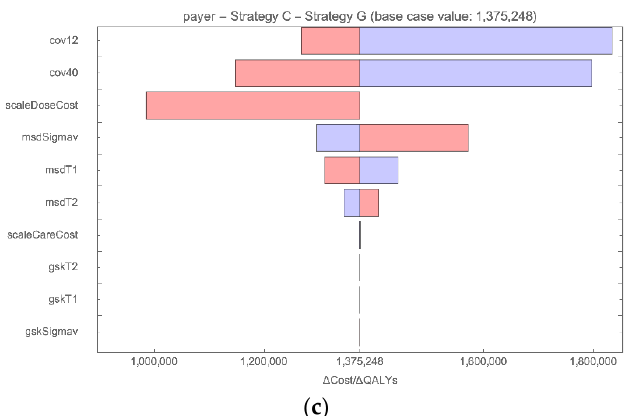
Figure 4. Tornado diagram DSA for strategies on the frontier from the payer perspective for ( a ) Strat- egy A vs. no UVV; ( b ) Strategy G vs. Strategy A; ( c ) Strategy C vs. Strategy G). ICERs based on lower bound (red) and upper bound (blue) parameter values. cov12 : coverage rate for vaccination at month 12; cov40 : coverage rate for vaccination at month 40; gskSigmav : GSK vaccine, average duration of protection; gskT1 : GSK vaccine, 1st dose take; gskT2 : GSK vaccine, 2nd dose take; msd- Sigmav : MSD vaccine, average duration of protection; msdT1 : MSD vaccine, 1st dose take; msdT2 : MSD vaccine, 2nd dose take; scaleCareCost : multiplier for disease-related costs; scaleDoseCost